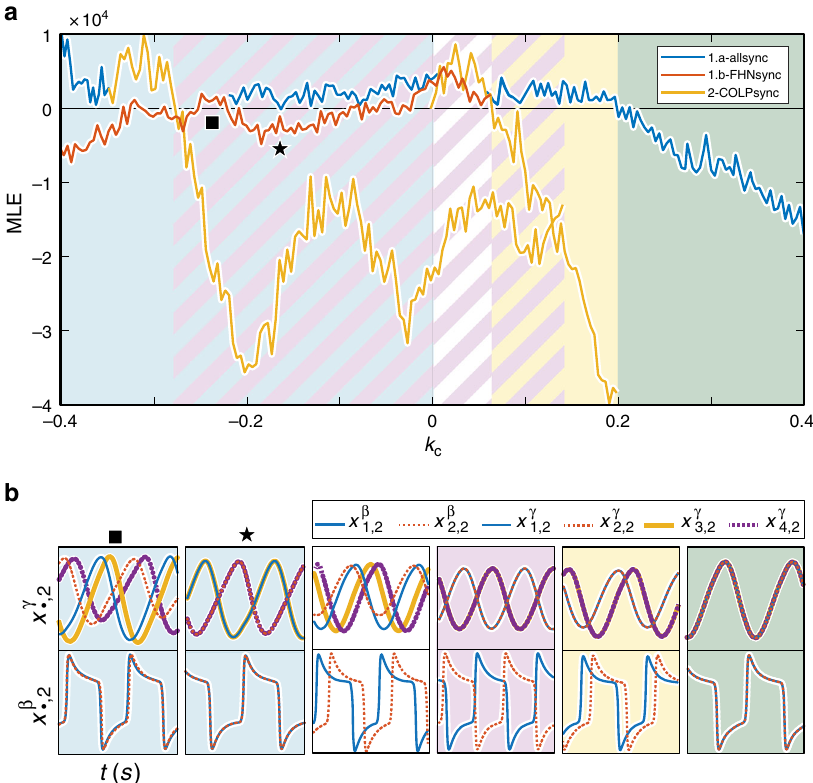
Fig. 6 Onset of different cluster synchronization patterns as varying k C . We observe fi ve kinds of clustered behavior, which are denoted by the shading of the background. Shading with two-colored striping indicates bistability between the two states represented by each color. a MLE transverse to each identi fi ed clustered solution. Green: Pattern 1a; Yellow: Pattern 2-( π /2); Lavender: Pattern 2-( π ); Blue: Pattern 1b; and White: no pattern. b different stable solutions present in each of the structurally different regions (identi fi ed by a bifurcation of a stable solution both in one of the quotient networks or transverse to them). Star: a stable solution of kind 1b occurs when the red line is negative; Square: a modi fi ed version of kind 1b occurs when the red line is